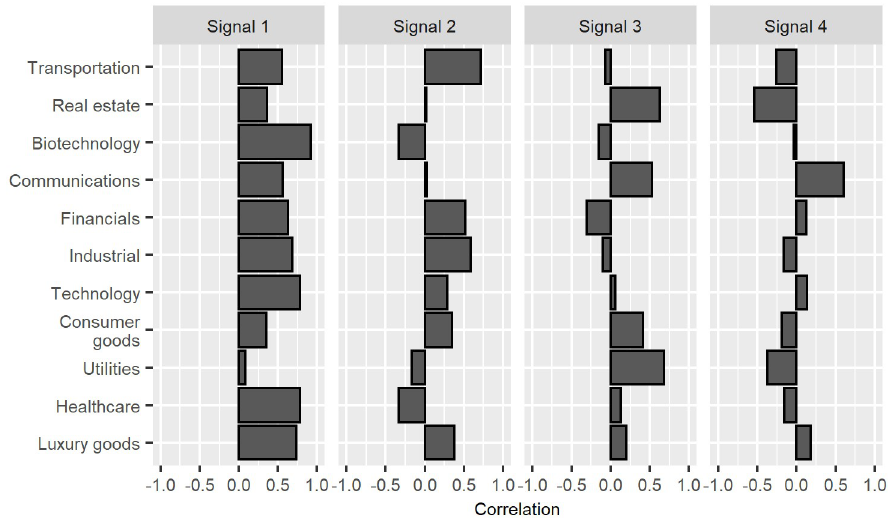
Fig 1. Correlation of variables (daily returns) with four leading signals extracted from the financial